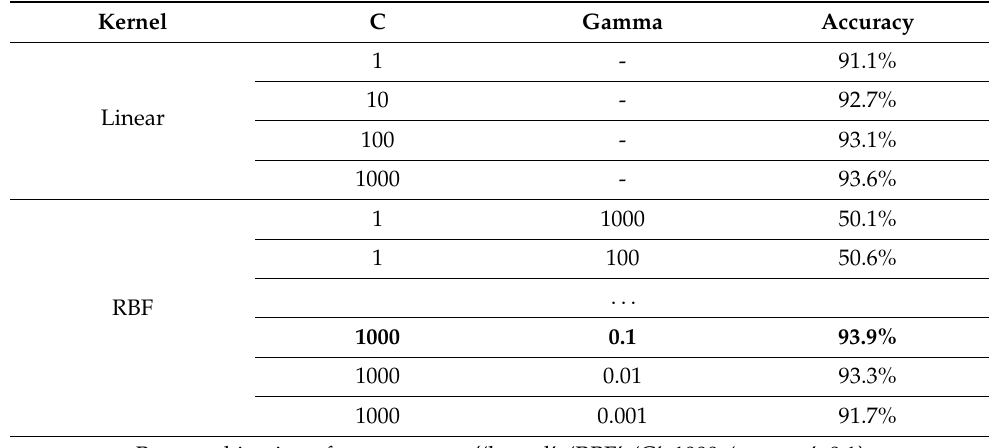
Table 4. SVM GridSearchCV-dataset